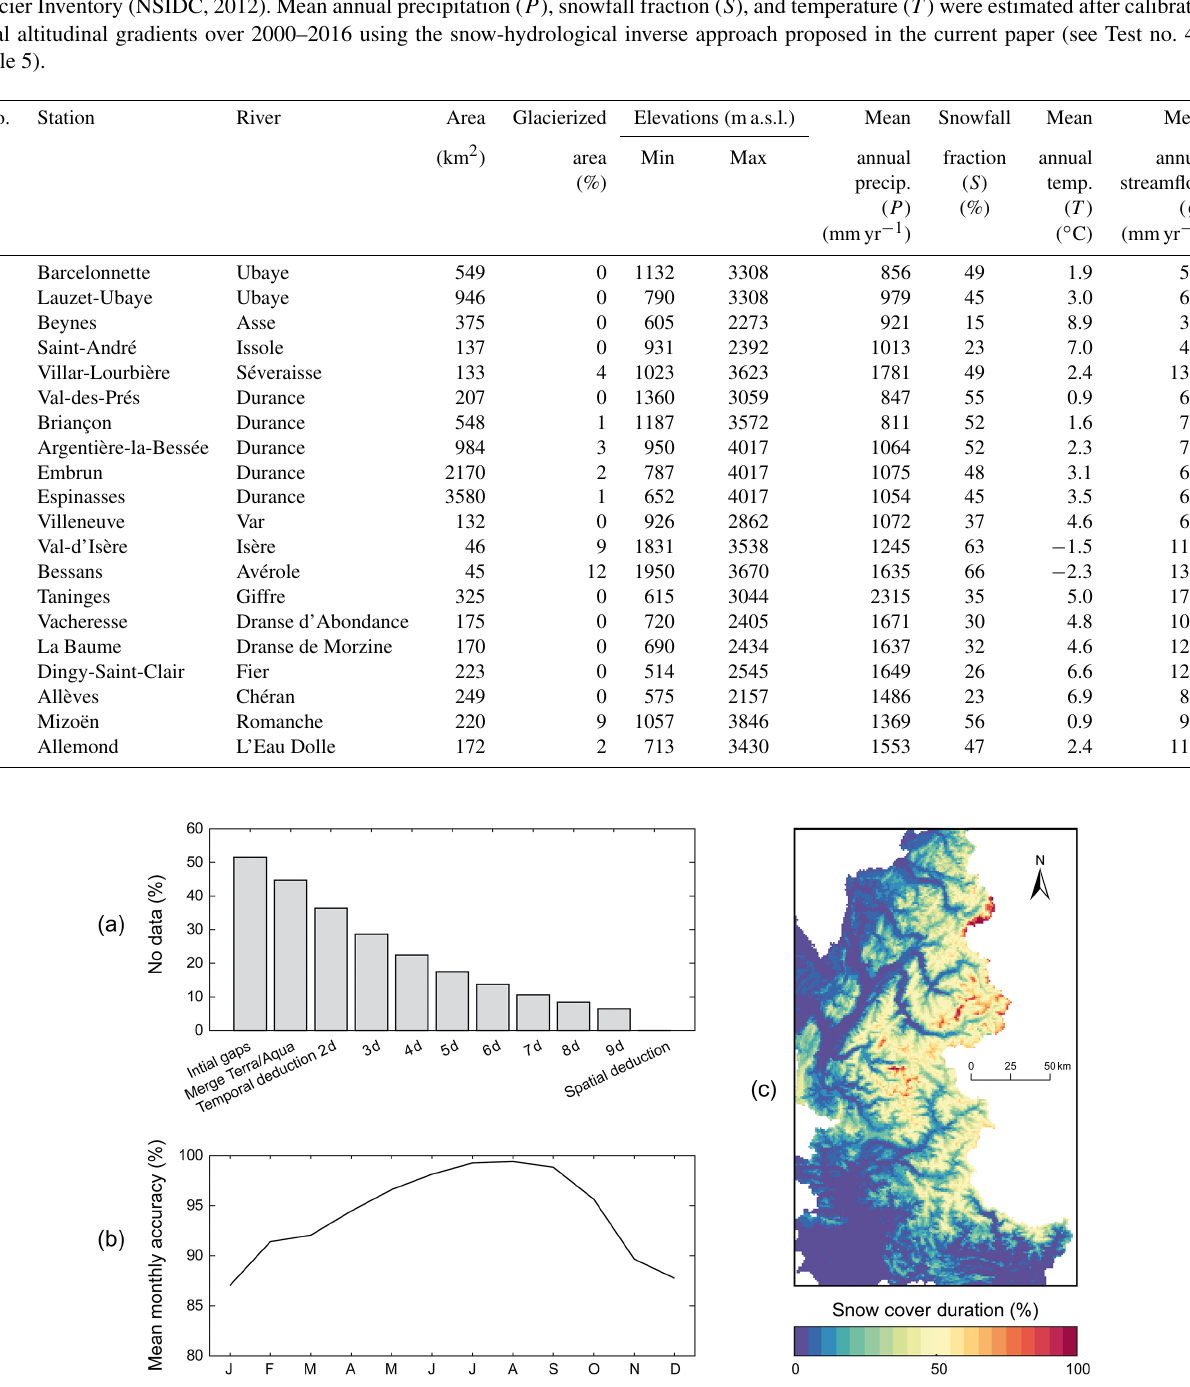
Figure 2. Results of gap-filling applied to MODIS snow products: (a) evolution of the number of pixels classified as no-data (e.g. clouds) during the gap-filling procedure; (b) mean monthly accuracies according to validation based on confusion matrices with one image per month, i.e. ∼ 200 cloud-free images over the 2000–2016 period; (c) snow-cover duration based on gap-filled MODIS snow products over the 2000–2016